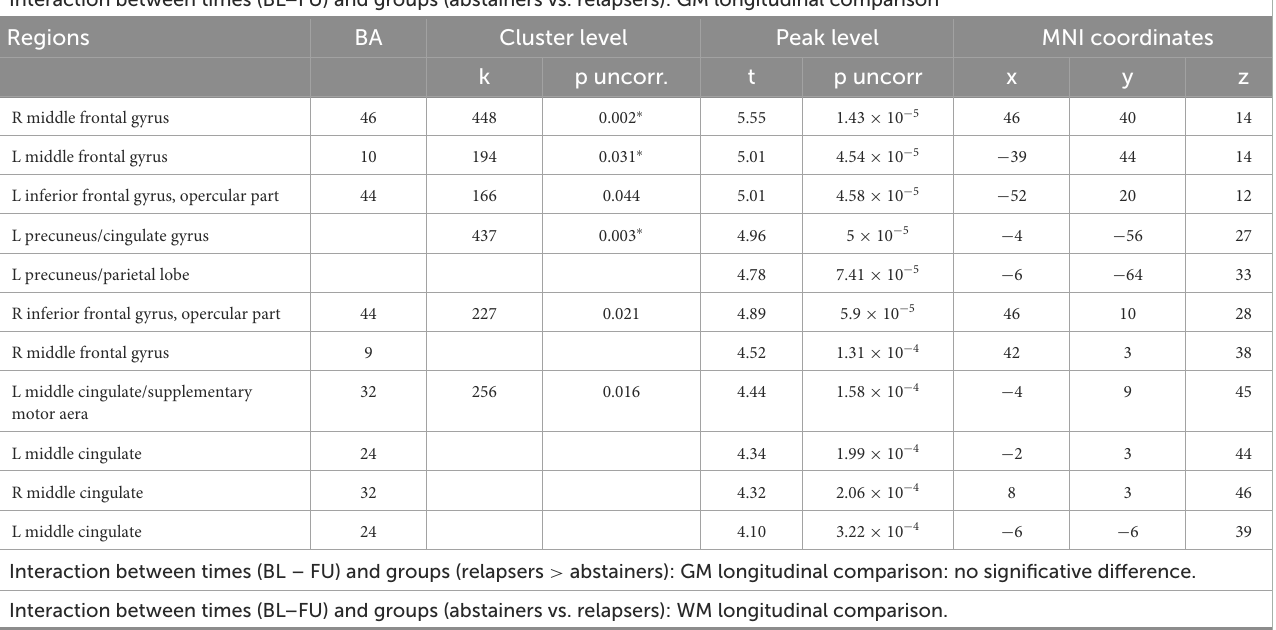
Interaction between times (BL – FU) and groups (relapsers > abstainers): GM longitudinal comparison: no significative